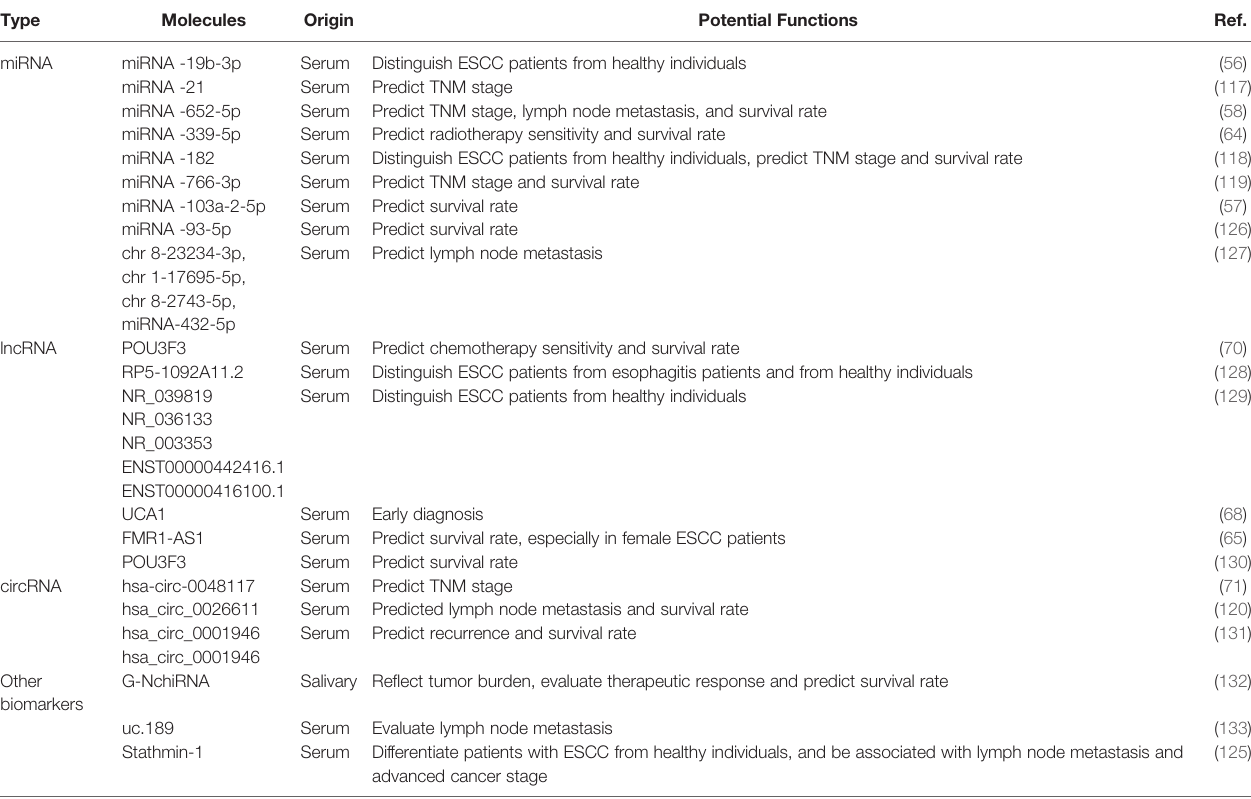
TABLE 2 | Exosomal cargos as biomarkers for